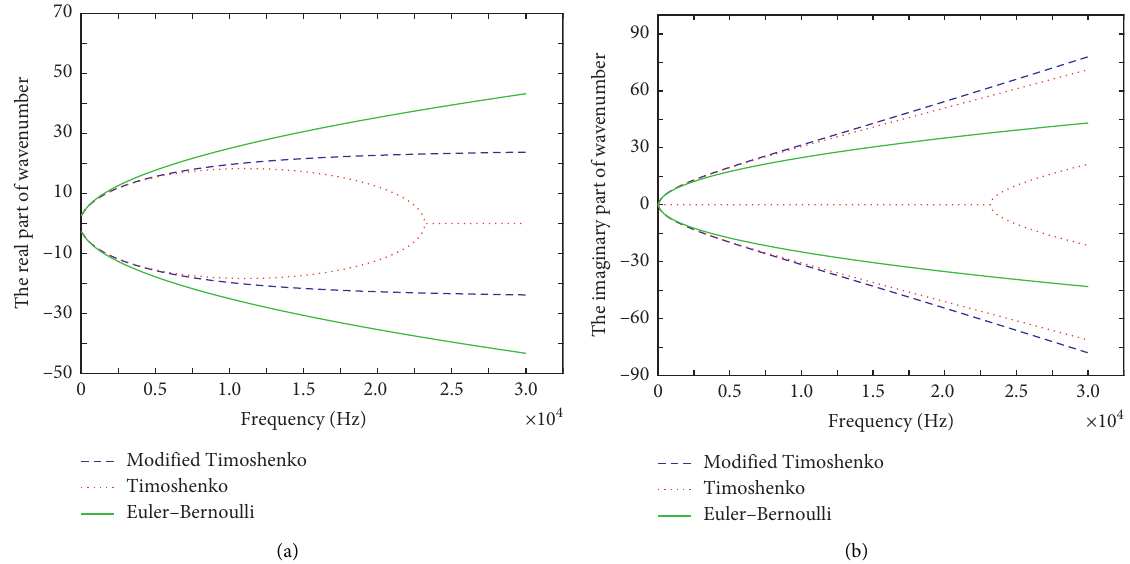
Figure 2: Wavenumber frequency diagram corresponding to (a) the real part of wavenumber; (b) the imaginary part of the